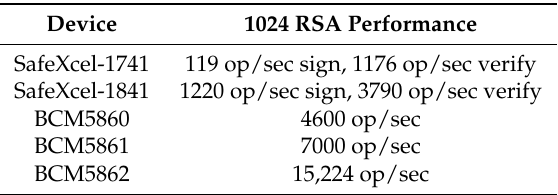
Table 1. RSA (Rivest-Shamir-Adleman) performance for different